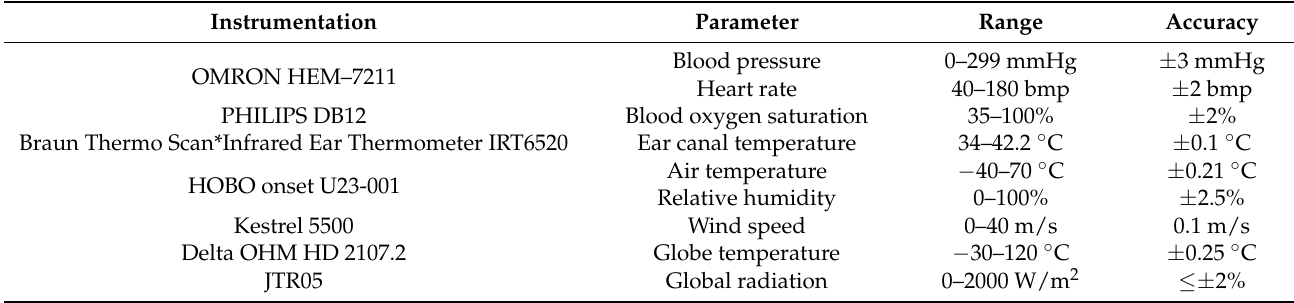
Table 2. Instruments